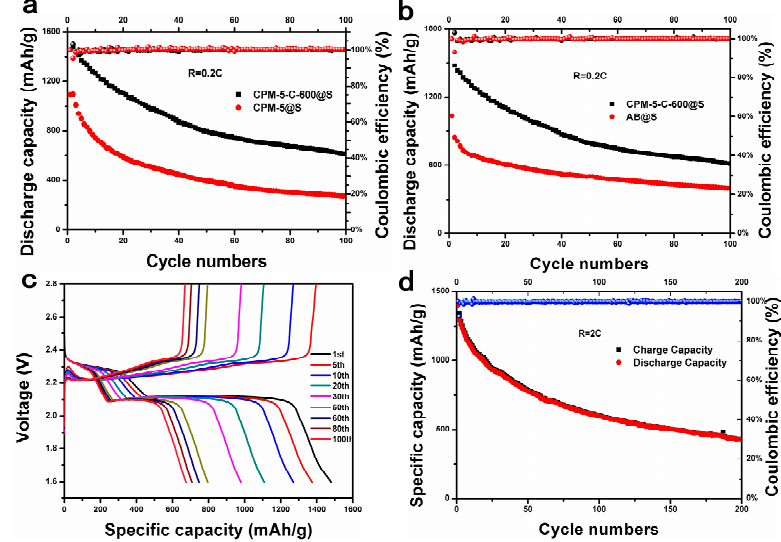
Figure 7. ( a ) Cycling performance of CPM-5-C-600@S and CPM-5@S electrodes at 0.2 C. ( b ) Cycling performance of CPM-5-C-600@S and AB@S electrodes at 0.2 C; ( c ) Discharge/charge curves of CPM-5-C-600@S electrodes at 0.2 C; ( d ) Cycling performance of CPM-5-C-600@S electrodes at 2 C.